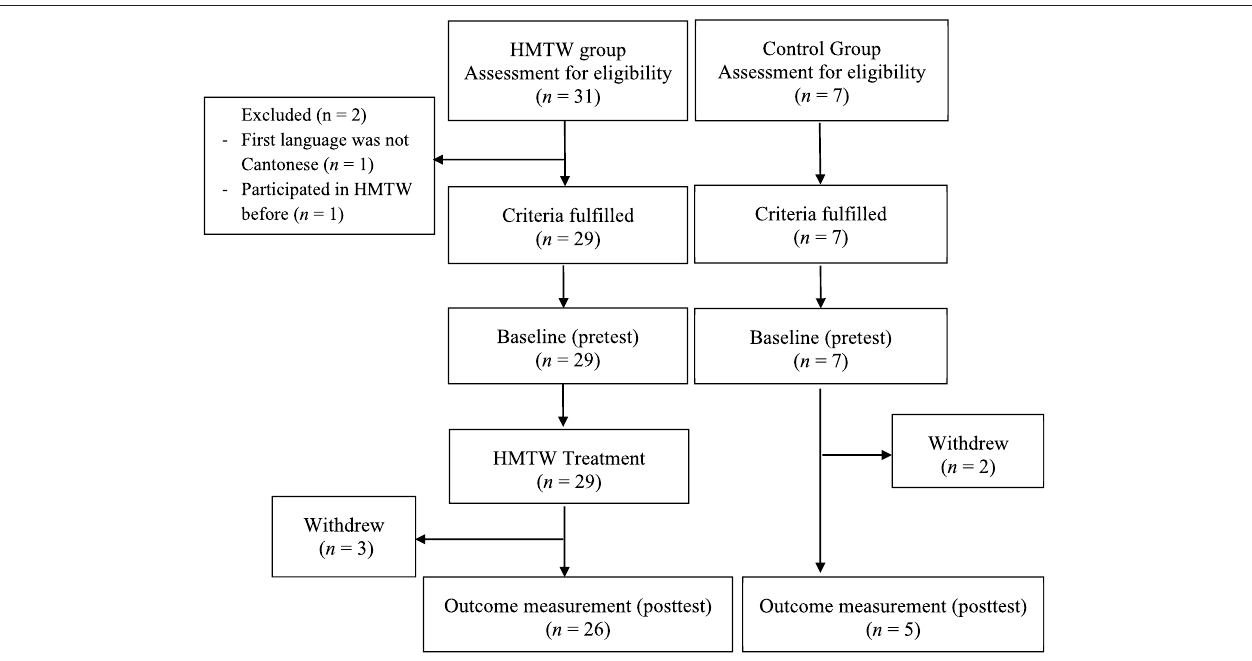
FIGURE 1 | Participant fl ow throughout the study. HMTW, Hanen More Than Words group; Control, Control group.